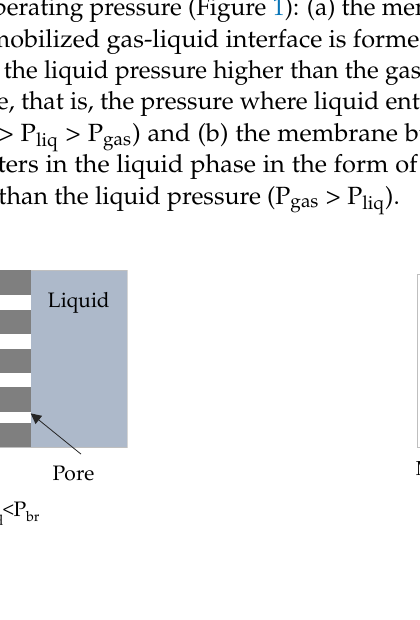
Figure 1. Cross section of a hydrophobic membrane ( a ) in contactor mode, ( b ) in bubbling mode.